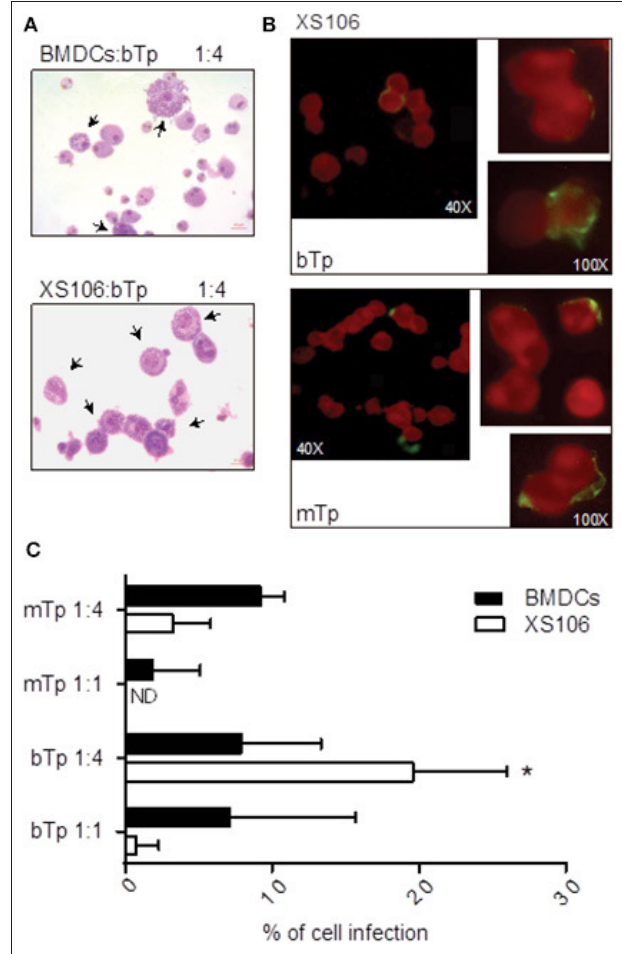
FIGURE 3 | XS106 cell line and BMDCs were differently infected by bTp and mTp. XS106 cells and BMDCs were cultured with bTp or mTp at different cell-to-Tp ratios (1:1 or 1:4). Cell infection was analyzed by optic microscopy after Giemsa staining, at 8 days post-infection (A) , 5 days post-infection (C) , or by fluorescence microscopy in XS106 cells (B) at 5 days post-infection, as described in materials and methods. Mean ± SEM ( n = 3, 15 random fields counted per treatment). * p < 0.05; unpaired Student’s t -test. Arrows shown cells with intracellular amastigotes. Bar size: 10 µ m (A)